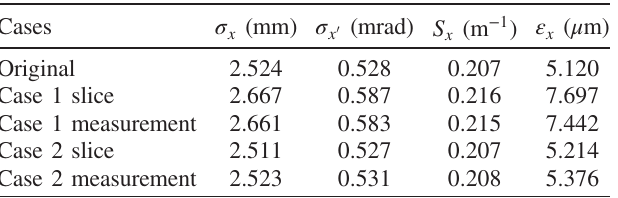
SINGLE-SHOT MEASUREMENT OF TRANSVERSE TABLE II. Comparison of calculated emittances from simu- lations. Second moments of the original case correspond to those of the entire beam. Second moments of the case 1 and case 2 slice correspond to the single slice and multislice ’ s second moments, respectively. Case 1 and 2 measurement shows the estimated second moments from the reconstruction using the projection method in simulation. The multislit used for the multislice case consists of five slits with a 100 μ m opening, and the slits are separated by 2.8 mm. Cases